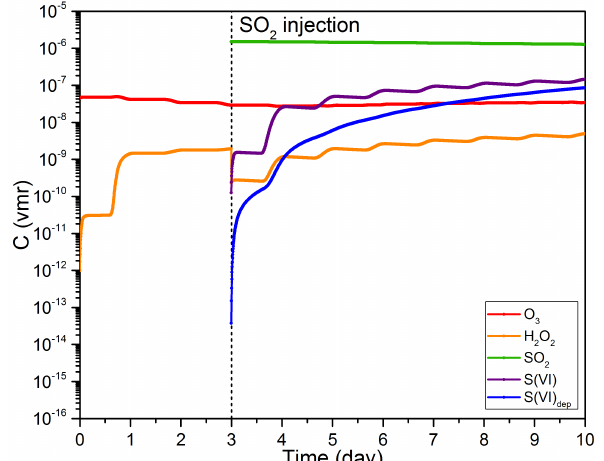
Figure 3. Time evolution of (cid:49) 17 O(S ( VI ) ) in produced and de- posited sulfates, and of the pH of the liquid phases in volcanic plumes during simulation S1, following the injection of SO 2 in the box. The change of pH in water droplets is also reported as a func- tion of